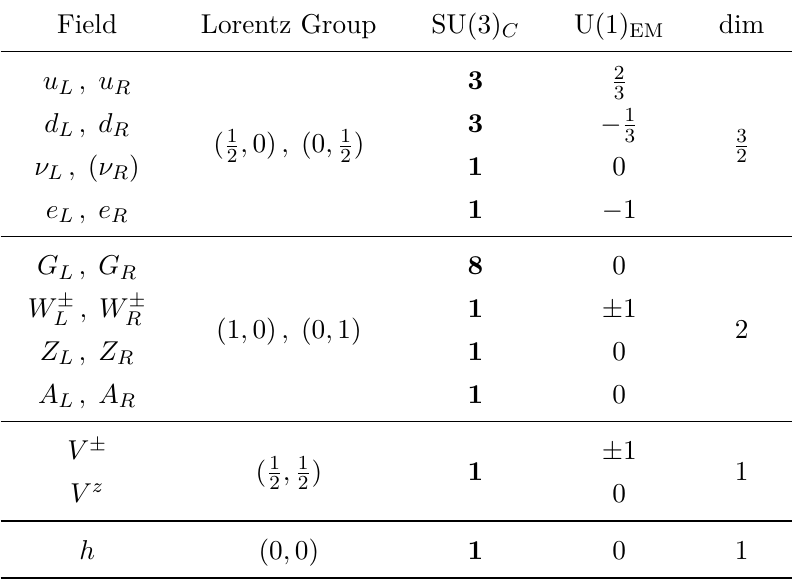
Table 2 . ( ν )HEFT field representations under spacetime and internal symmetry groups. The corresponding canonical mass dimensions are also listed. The linearized Goldstone fields V ± , V z have mass dimension one, as they contain one power of